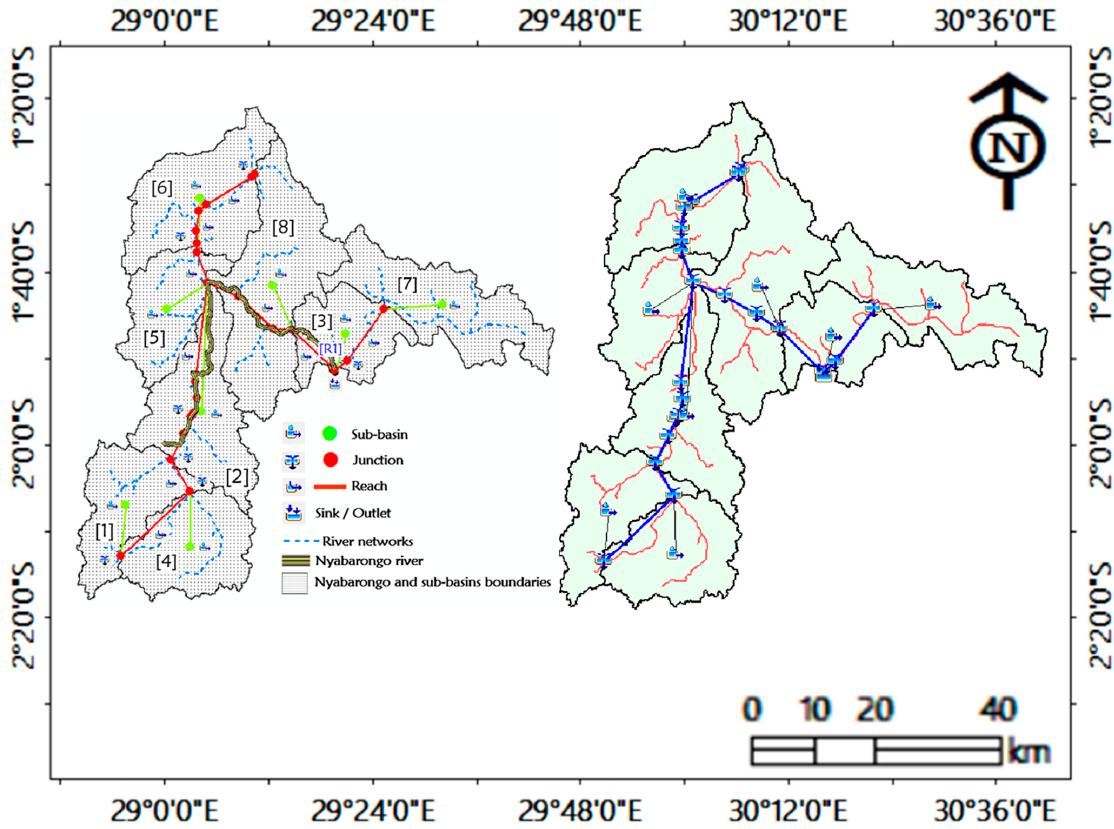
Figure 5. Basin model with topological connections between catchment features determining flow connectivity (designed using ArcGIS and HEC-HMS software) while the numbers in brackets represent the subbasins.